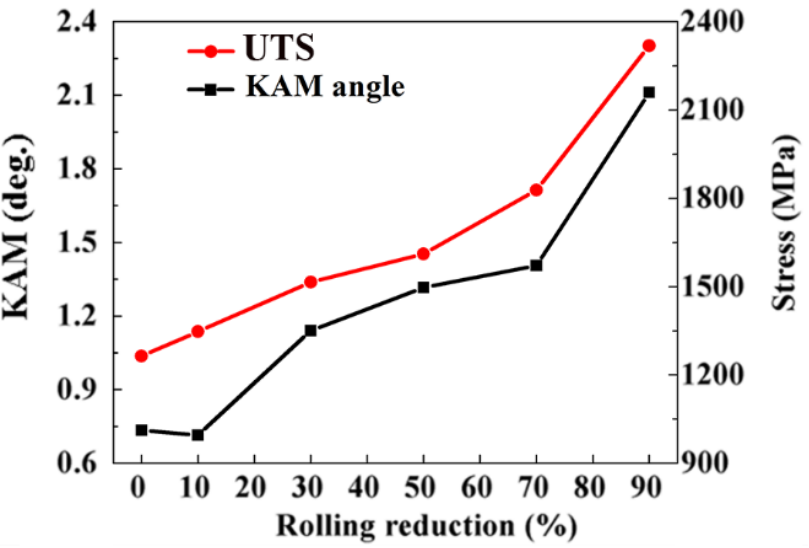
Figure 6. Average KAM angle and UTS of the cold-rolled SK85 steel at various rolling reductions.